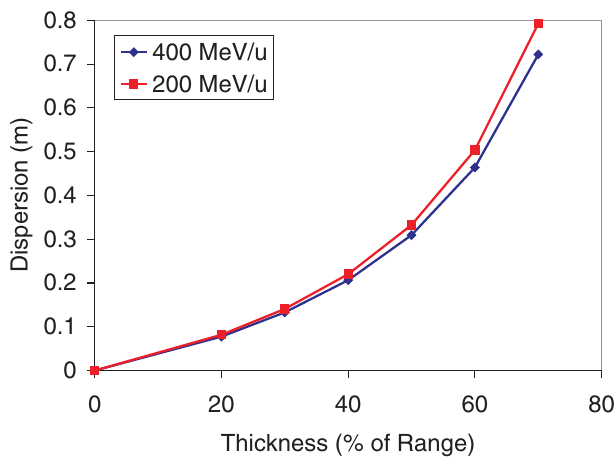
FIG. 2. (Color) Effect of not shaping the degrader: dispersion introduced at the location of the no-wedge achromatic